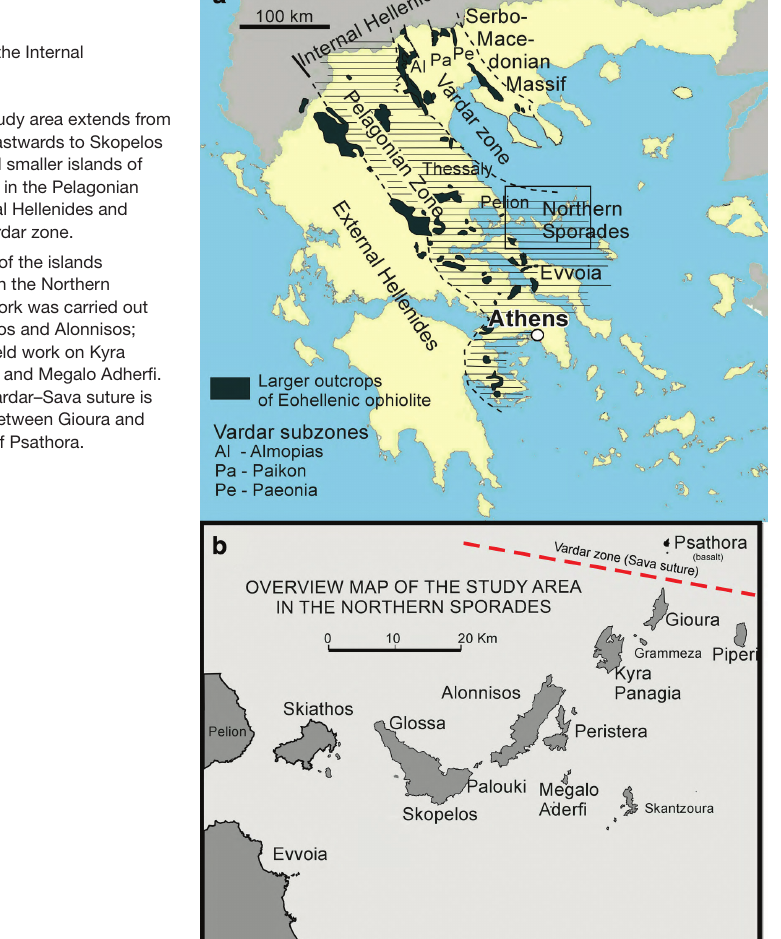
The study area in the Internal hellenides. (a) The outlined study area extends from northern Evvoia eastwards to skopelos and alonnisos and smaller islands of the sporades. It is in the Pelagonian zone of the Internal hellenides and borders on the Vardar zone. (b) Overview map of the islands of the study area in the Northern sporades. Field work was carried out on Evvoia, skopelos and alonnisos; reconnaissance field work on Kyra Panagia, Peristera and Megalo adherfi. The Pelagonian/Vardar–sava suture is suggested to lie between Gioura and the basalt island of